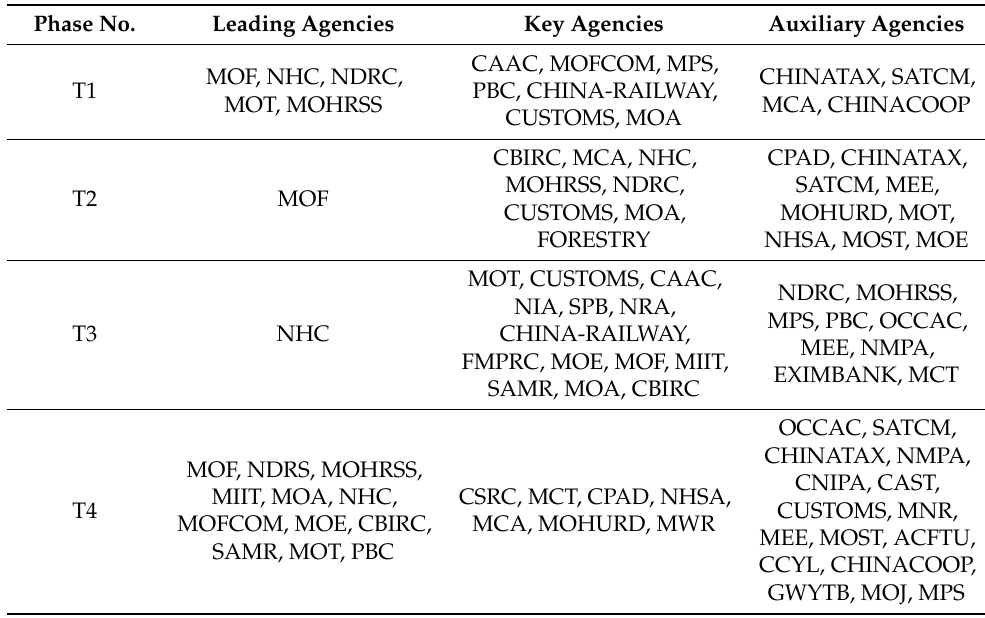
Table 2. Role evolution of agencies involved in the